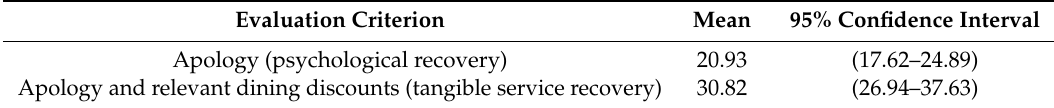
Table 7. Estimated result of the WTW associated with restaurant service recovery (Weibull